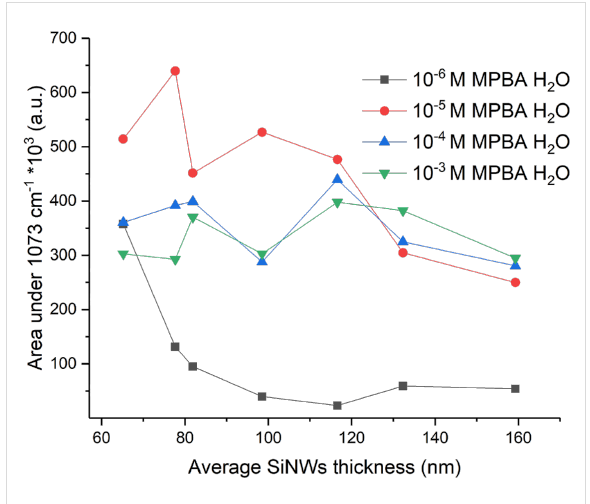
Figure 6: Average SERS values of 4-MPBA for different SiNW thick- nesses after H 2 O immersion.